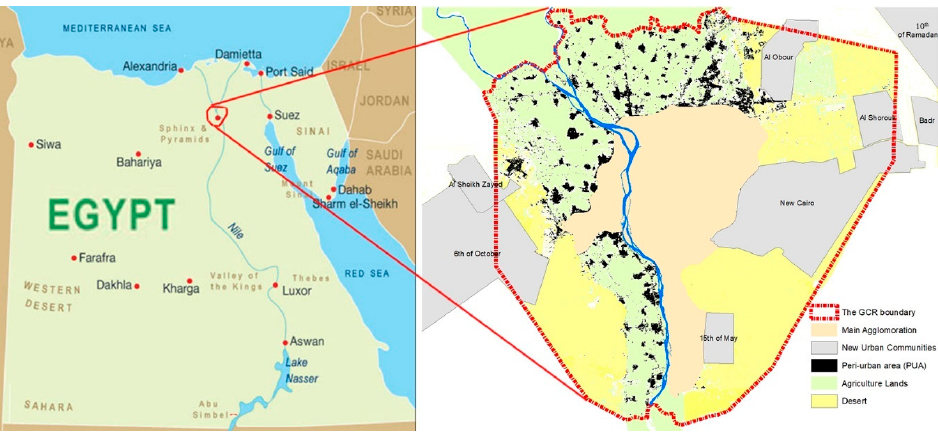
Figure 1. Study area.